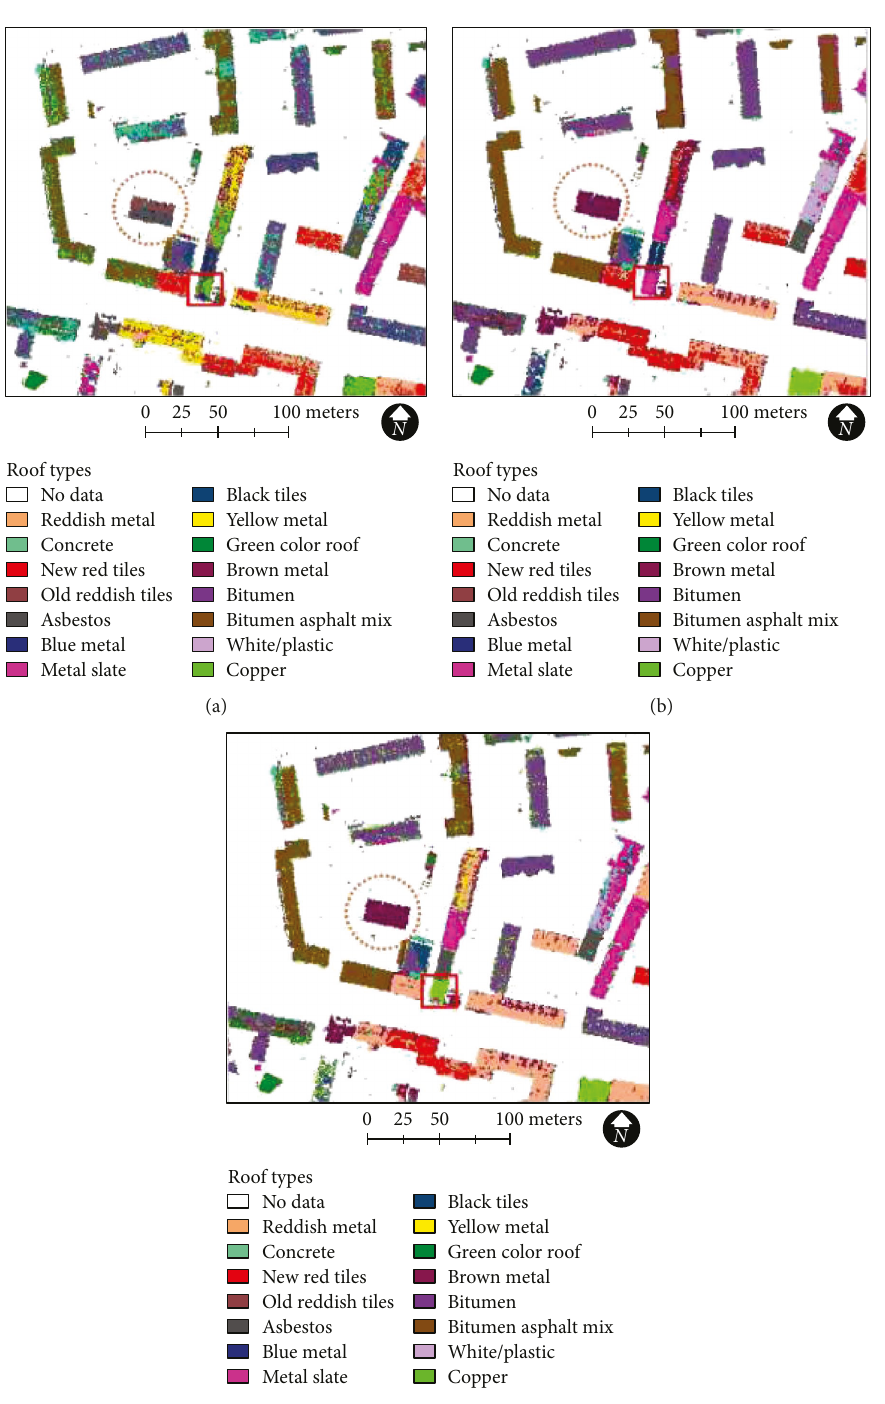
Figure 4: Classi fi cation result of 48 bands using (a) SAM, (b) ANN, and (c) SVM classi fi er. Dotted circle and square are used to compare the classi fi